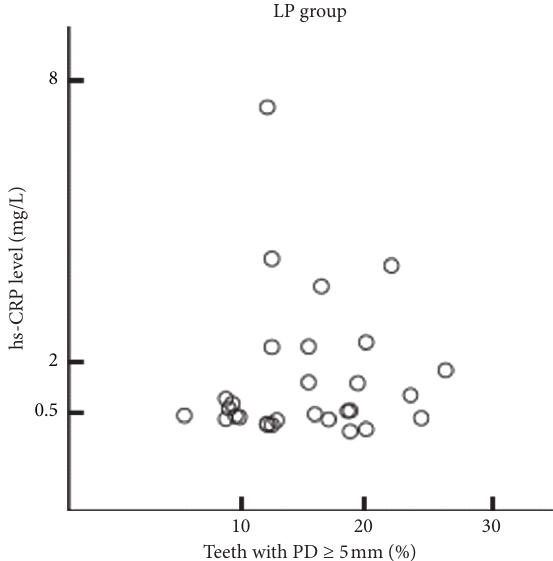
Figure 5: Matrix scatter plot of the proportion of teeth with ≥ 5mm PD and CRP concentration in the CPL group. The proportion of teeth with ≥ 5mm PD was not significantly associated with CRP concentration in the CPL